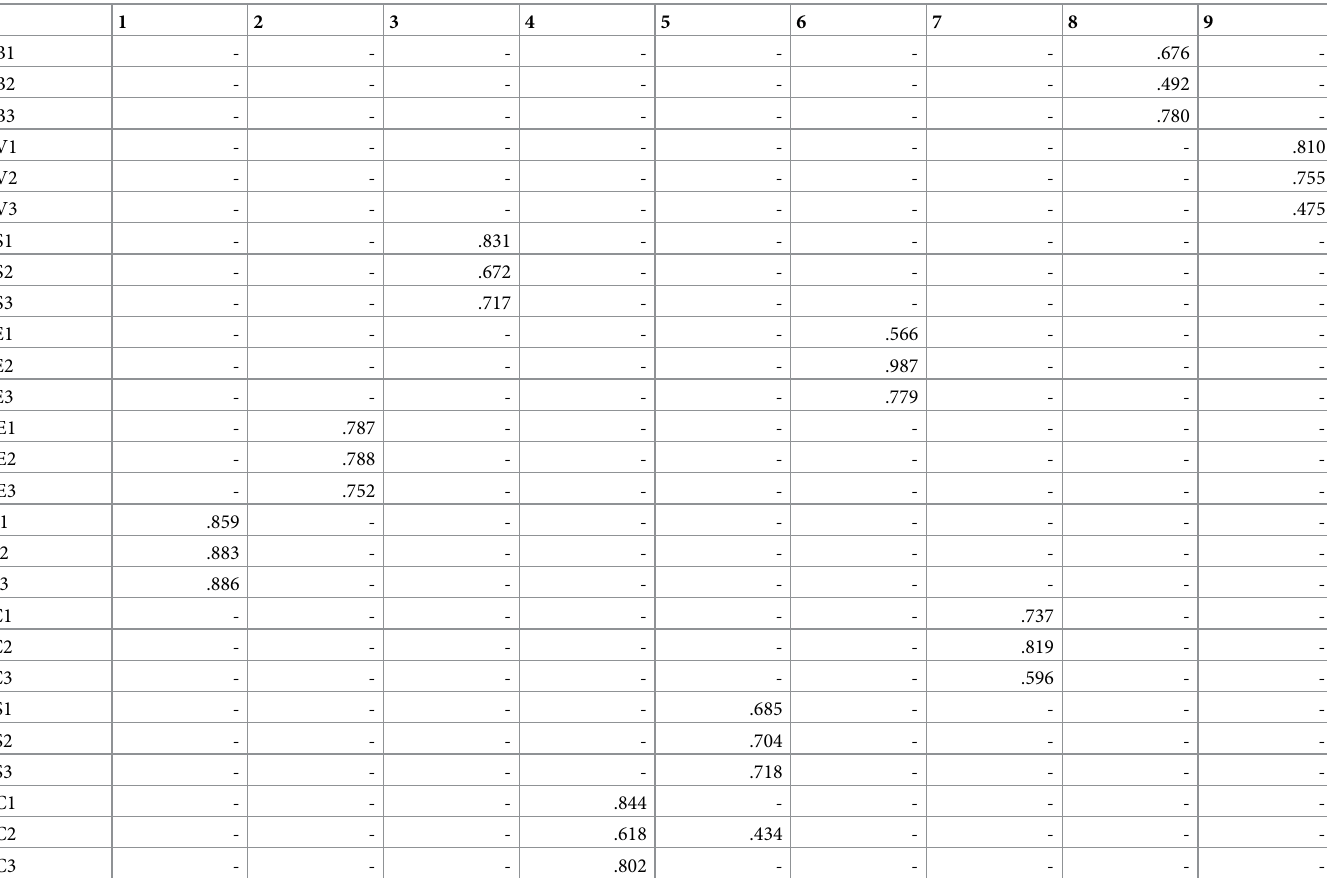
Table 2. Rotated factor matrix with factor loadings (loadings lower than .35 are